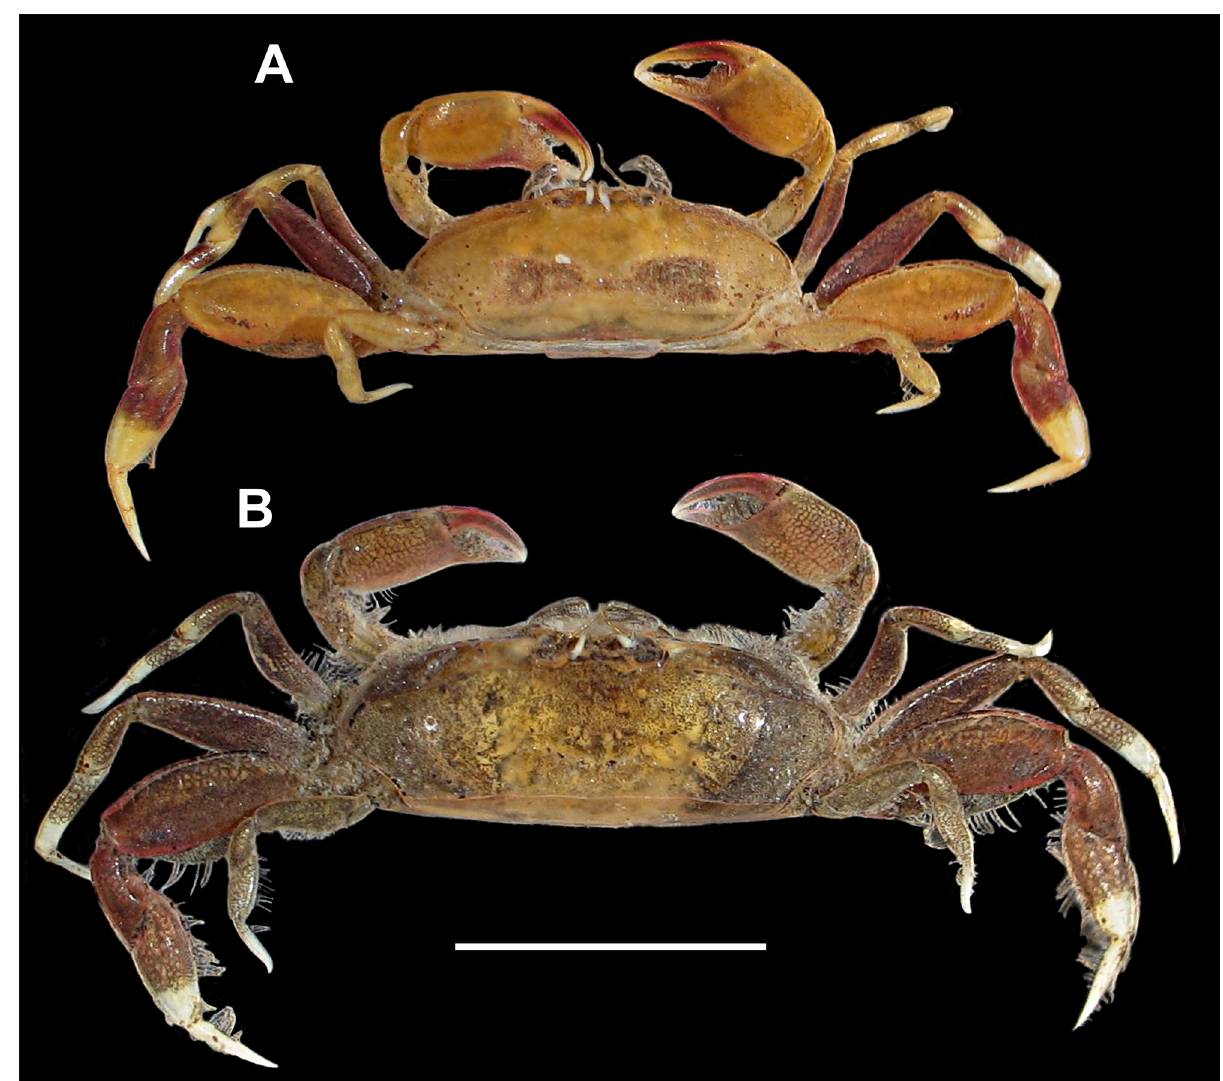
Figure 2. Austinixa marianae n. sp., color in life. A , Male paratype ICML-EMU 12532; B , female paratype, ICML-EMU 12532. Scale bar = 5